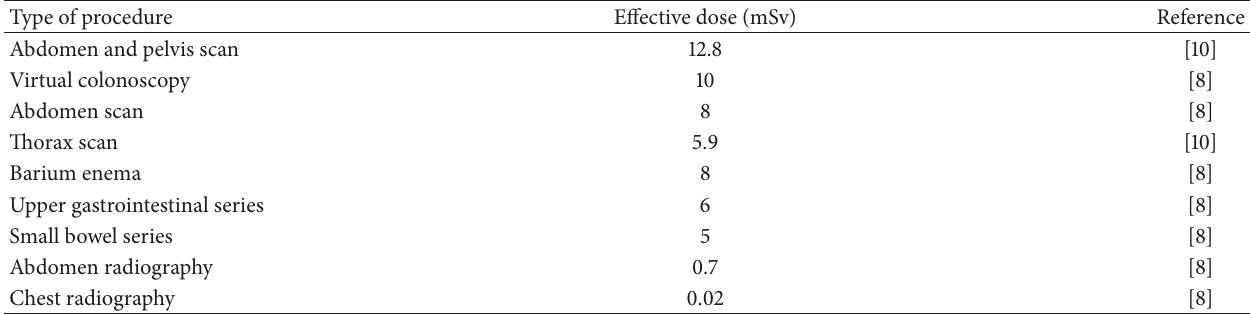
Table 1: Mean radiation dose for common diagnostic radiologic